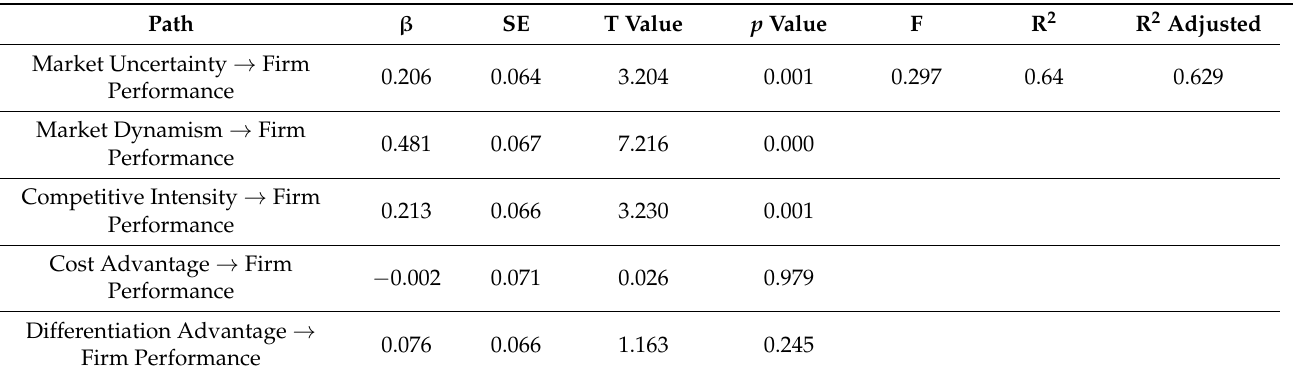
Table 5. Results of bootstrapping for path